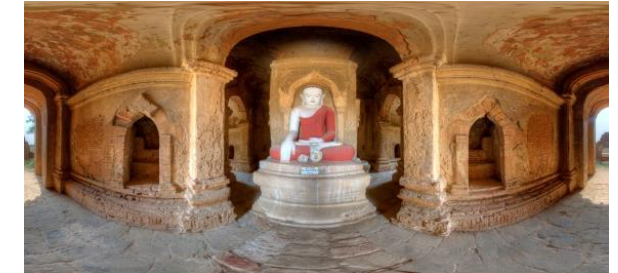
Figure 9: Panoramic Interior of temple Eim-Ya-Kyaung-Nga-Myet-Hna, East Entrance. Image source: Mario Santana